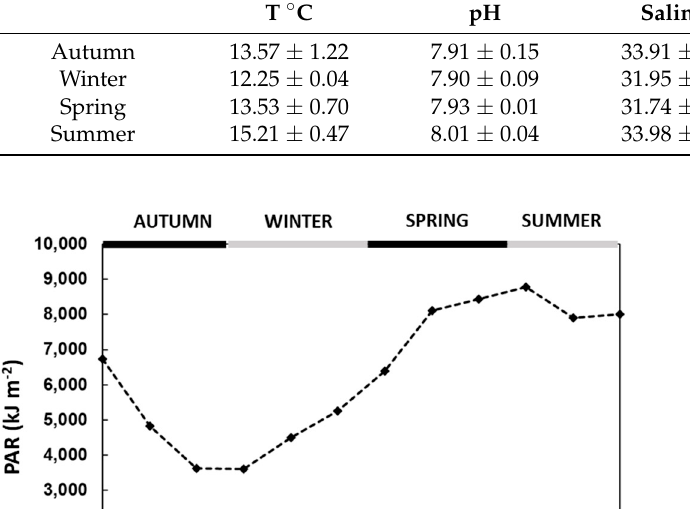
Table 1. Abiotic parameters: Temperature (T ◦ C), pH, salinity and PAR diffuse attenuation coefficients (K dPAR express in m − 1 ) measured in the water column in the Cochoa Beach (Reñaca—Chile), on a monthly basis from March 2019 to February 2020 along the autumn, winter, spring, and summer seasonal times. T ◦ C pH Salinity K dPAR Autumn 13.57 ± 1.22 7.91 ± 0.15 33.91 ± 1.13 0.360 Winter 12.25 ± 0.04 7.90 ± 0.09 31.95 ± 0.42 0.288 Spring 13.53 ± 0.70 7.93 ± 0.01 31.74 ± 0.25 0.304 Summer